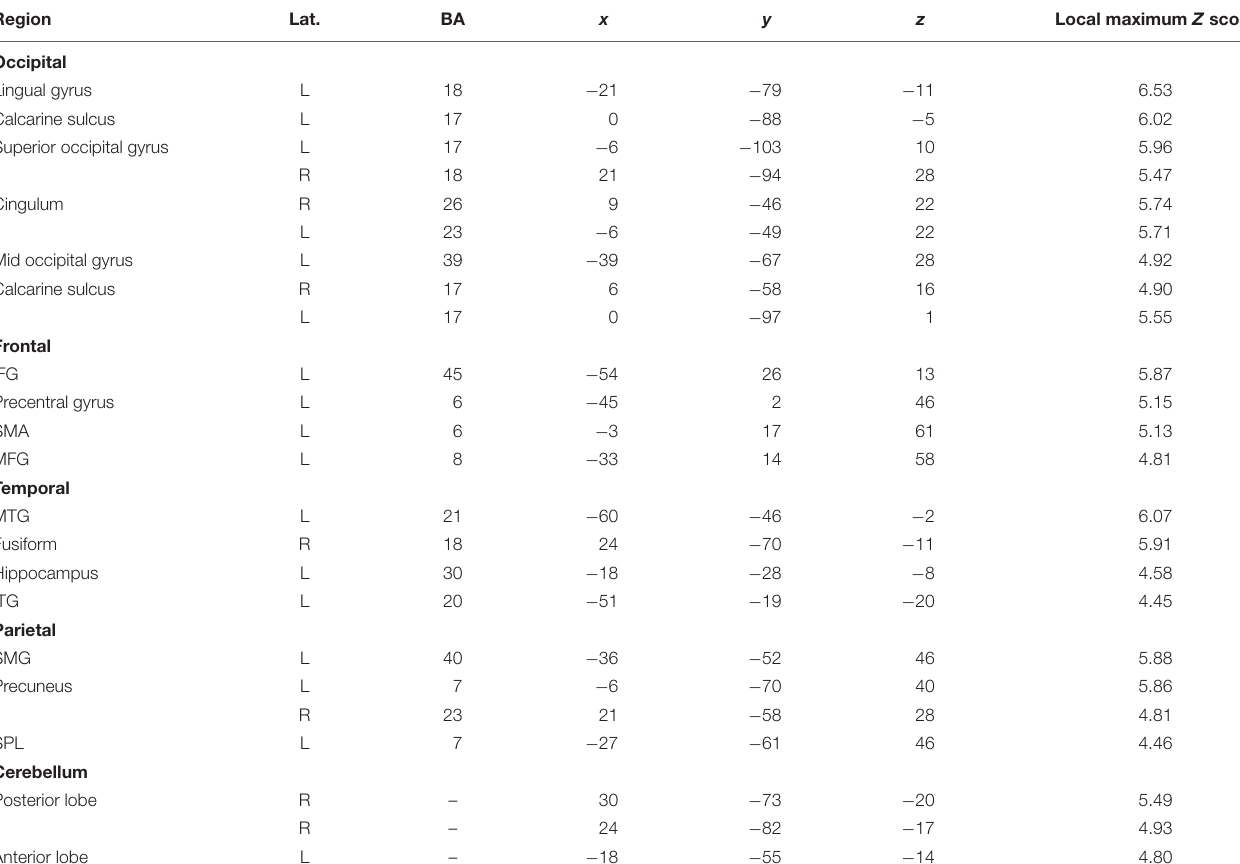
TABLE 2 | Local maxima from the major cluster activated during the think vs. no-think1 contrast. Region Lat. BA x y z Local maximum Z